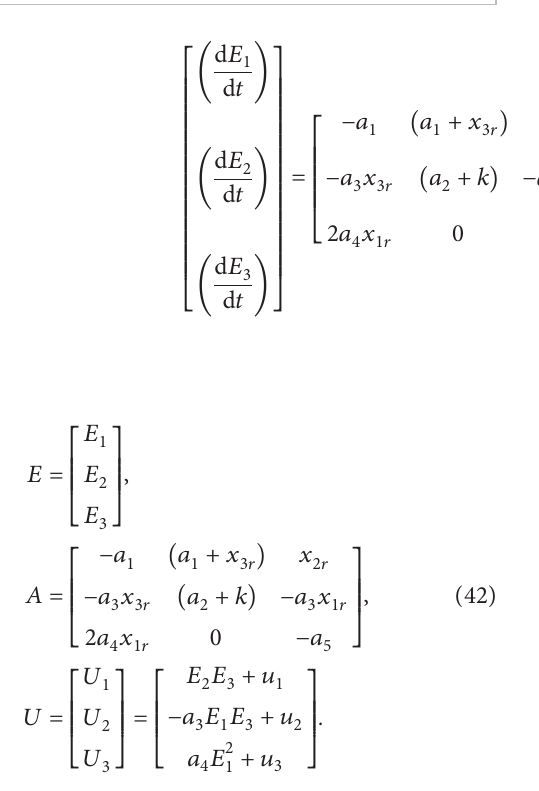
; (d) track control errors E 3